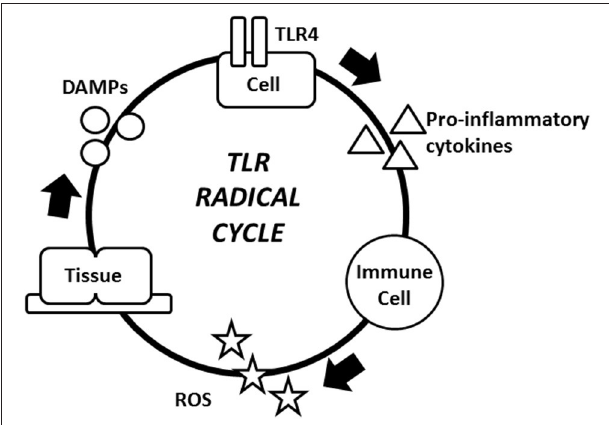
FIGURE 2 | The TLR radical cycle. The TLR4 receptor on any TLR4 expressing cell, e.g., an epithelial cell or a fibroblast is triggered by PAMPs and/or DAMPs. These immobile cells are part of the inflammatory cycle and they regulate the location of the inflammation. After TLR4 is activated, pro-inflammatory cytokines are released and started to attract macrophages, mast cells and neutrophils, ultimately leading to ROS production. ROS attack microbes, but also cause collateral damage to the cell. Endogenous molecules are modified by ROS and act as DAMPs to reactivate TLR4. The loop is then complete and another cycle may begin. The result of the cycle is the persistence of chronic inflammation. Abbreviations: DAMPs, damage-associated molecular patterns; PAMPs, pathogen-associated molecular patterns; ROS, reactive oxygen species; TLR4, toll-like receptor